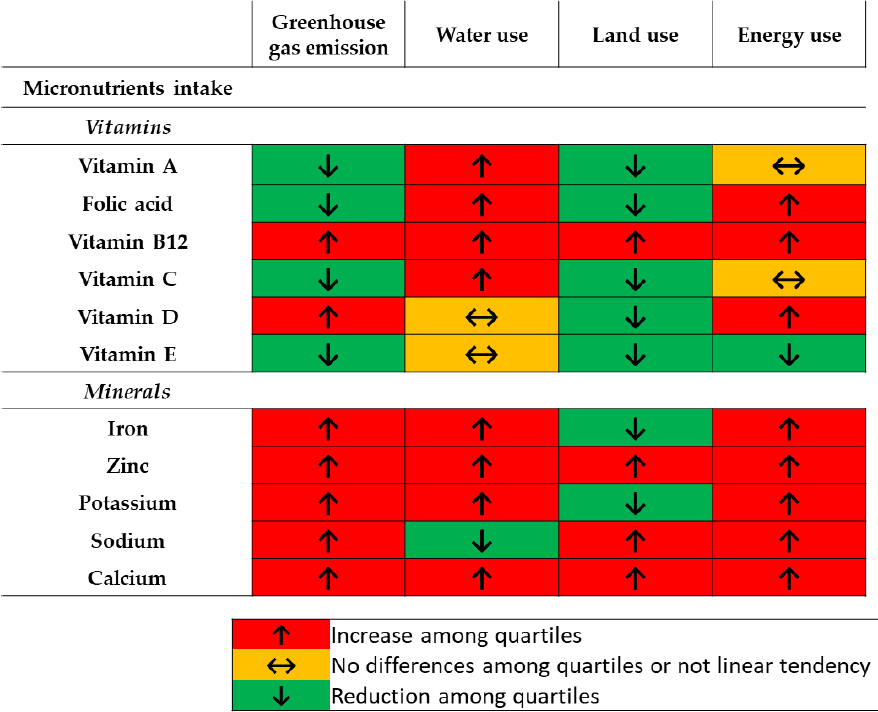
Figure 2. Tendencies in macronutrients intake among energy-adjusted quartiles of the indicated environmental impact indicators.